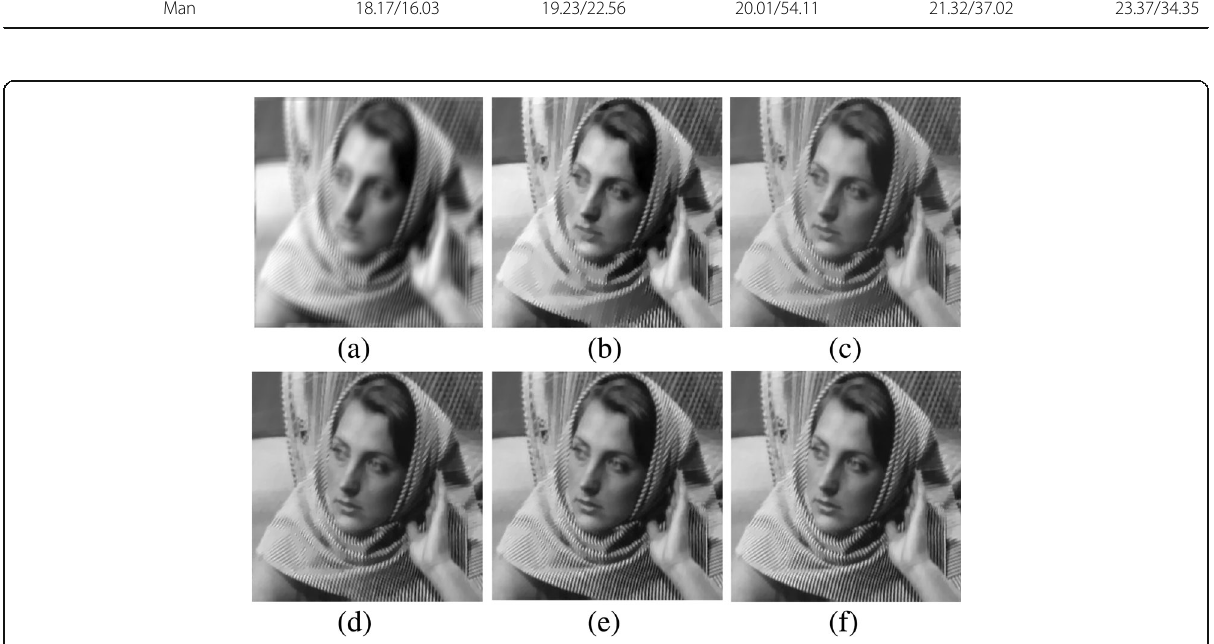
Fig. 5 Experiments on the blurred image “ Babara ” (degrade by a 19 × 19 kernel). a Blurred image(PSNR = 18.17). b The local TV [5] (PSNR = 20.12, t = 6.36 s). c GOS_TV [15] (PSNR = 21.38, t = 8.85 s). d The local/nonlocal TV [26] (PSNR = 22.89, t = 26.77 s). e The nonlocal TV [8] (PSNR = 23.34, t = 14.32 s). f The proposed model (PSNR = 24.93, t = 13.03